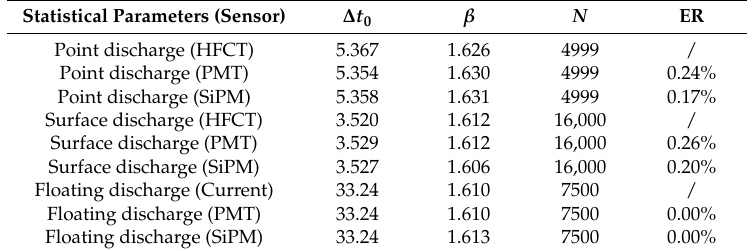
Table 2. Comparisons of Weibull parameters between the PD pulses detected by the current, PMT and